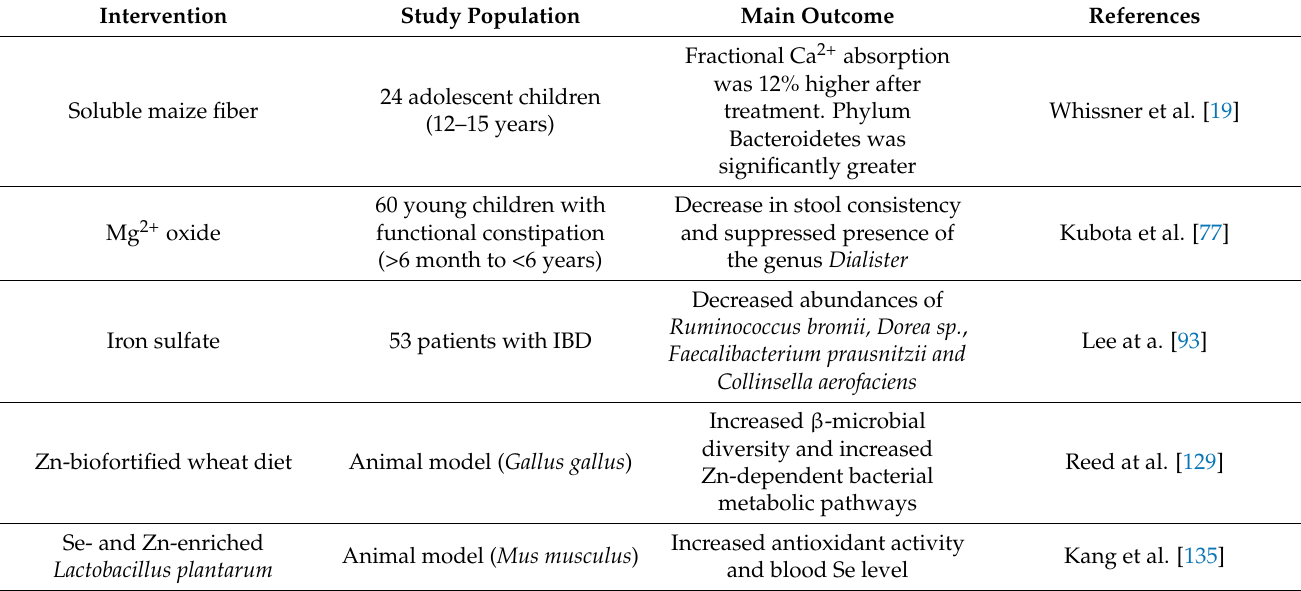
Table 1. Interaction between gut microbiome and